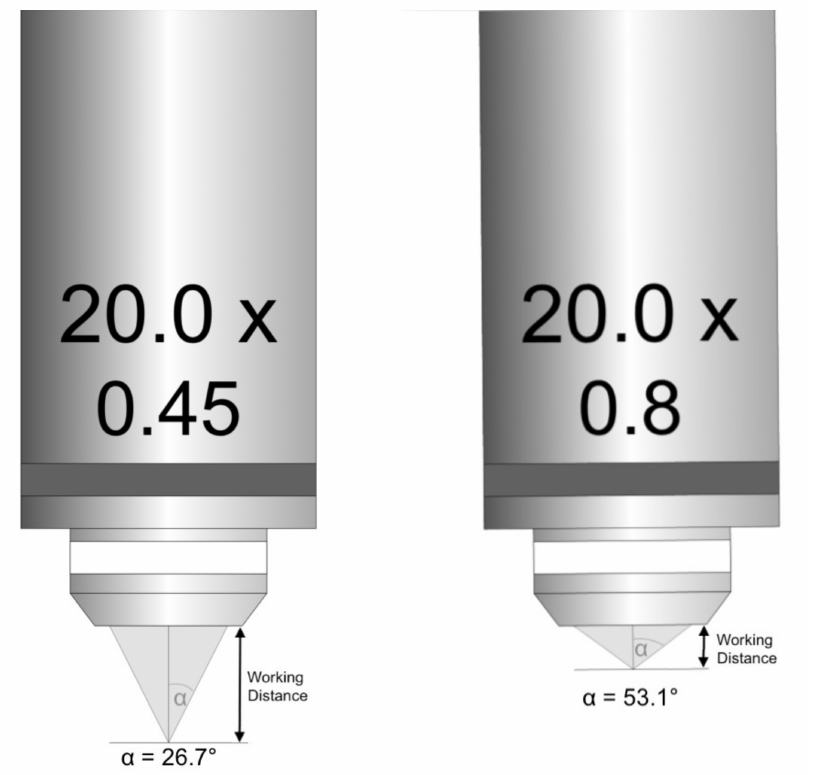
Figure 1. Inverse relationship of numerical aperture and working